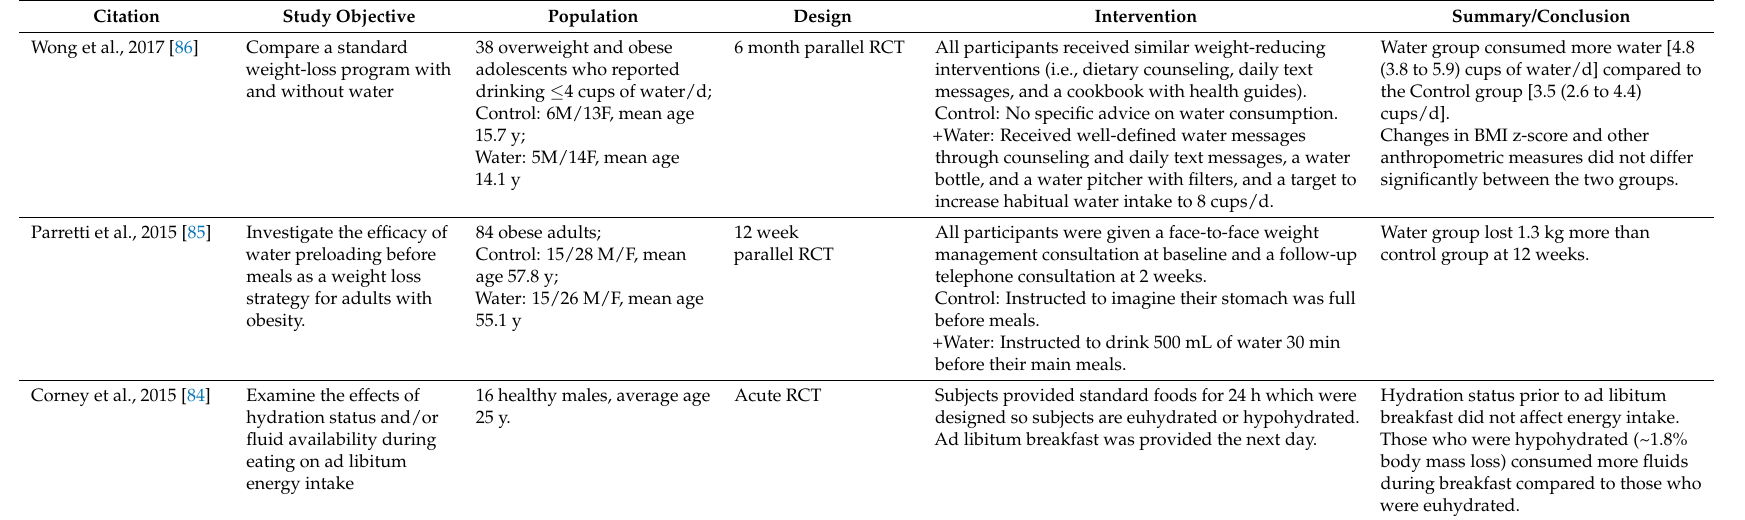
Table 4. Intervention Studies on Hydration and Weight Management 1